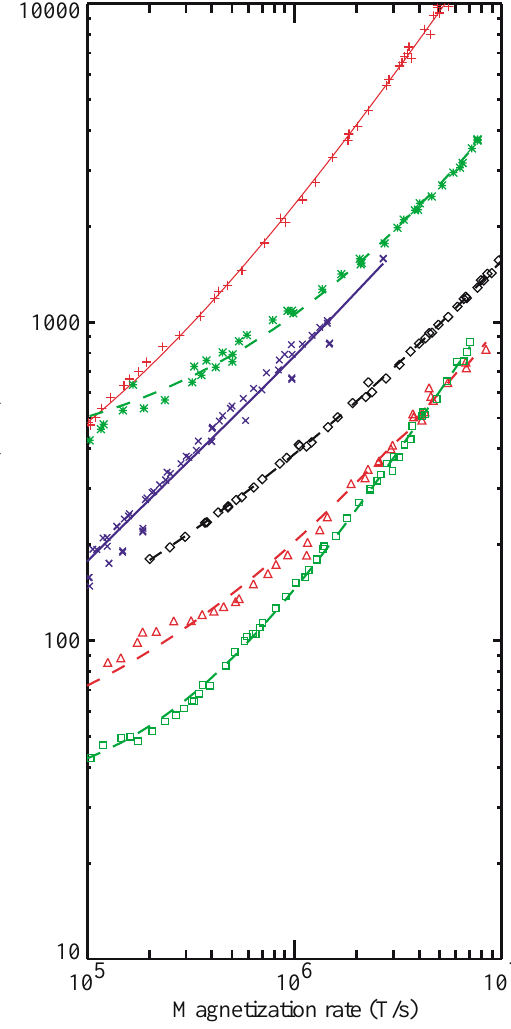
FIG. 6. (Color) Core loss versus magnetization rate for six cores, all annealed after winding. From the top, these are ( 1 , red, solid line) 50 m m thick 3% silicon steel with D B (cid:1) 3.3 T; ( (cid:2) , green, dashed line) 25 m m thick 3% silicon steel with D B (cid:1) 3.0 T; ( 3 , blue, solid line) METGLAS 2605 SA1 with magnesium methylate insulation with D B (cid:1) 2.7 T; ( } , black, dashed line) METGLAS 2605 SC cowound with mica paper insulation with D B (cid:1) 2.4 T; ( (cid:3) , red, dashed line) FINEMET FT-2H with D B (cid:1) 2.4 T; and ( (cid:1) , green, dashed line) FINEMET FT-1H with D B (cid:1) 2.1 T. Both FINEMET alloys are insulated with a glass